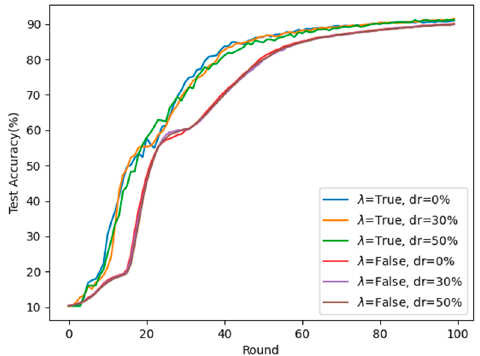
Figure 5. Accuracy by dropout rate and training weights ( λ ).